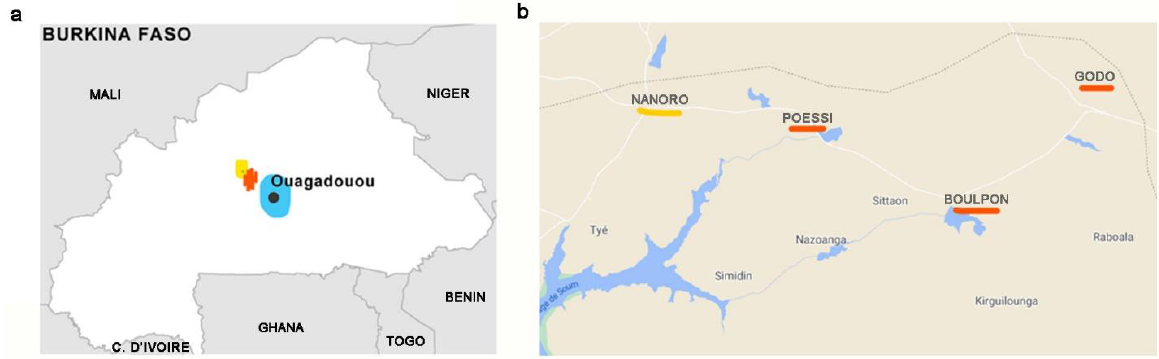
Figure 1. Map of Burkina Faso and areas of the three enrolled cohorts. ( a ) In blue: Urban area of the capital city Ouagadougou; in yellow: The small town of Nanoro (initial level of urbanization); in red: Rural area. ( b ) Detailed map. In red, the three rural villages of Boulpon, Godo and Poessi; in yellow, the town of Nanoro.